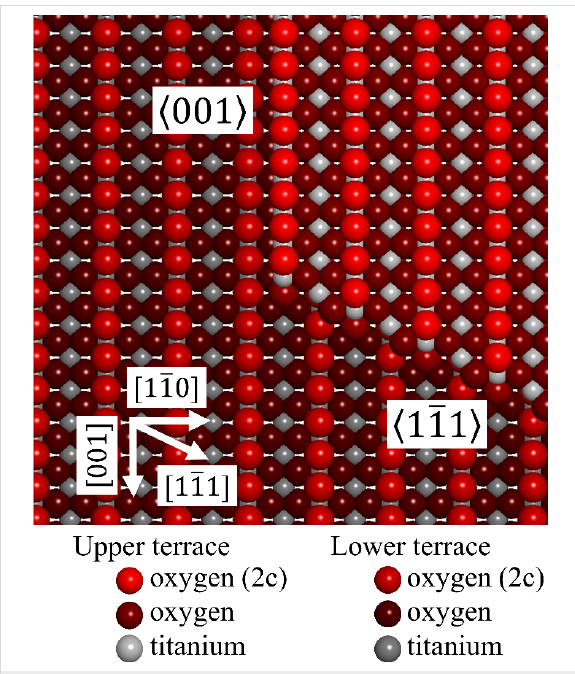
Figure 1: Ball model of TiO 2 (110)-(1 × 1) surface with two step struc- tures of and